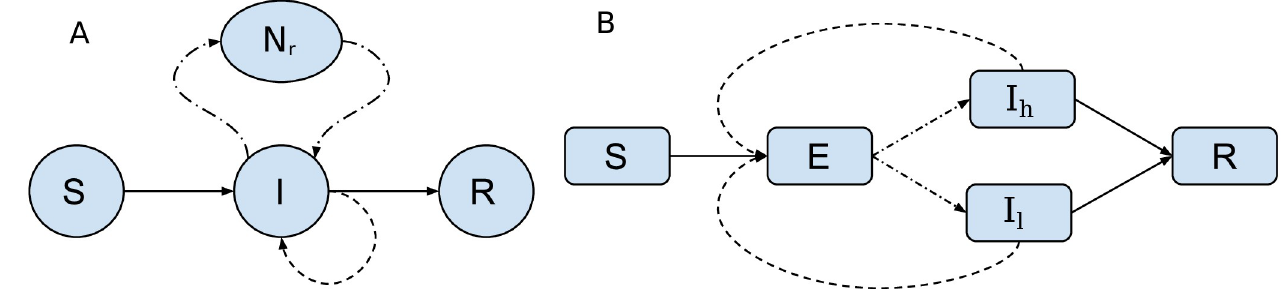
Fig 1. Compartmental diagram representing structure of models for seasonal human Influenza (A) and Ebola virus model (B). Solid lines represent flux of hosts between different categories. Dash lines represent migration. Dotted lines represent births